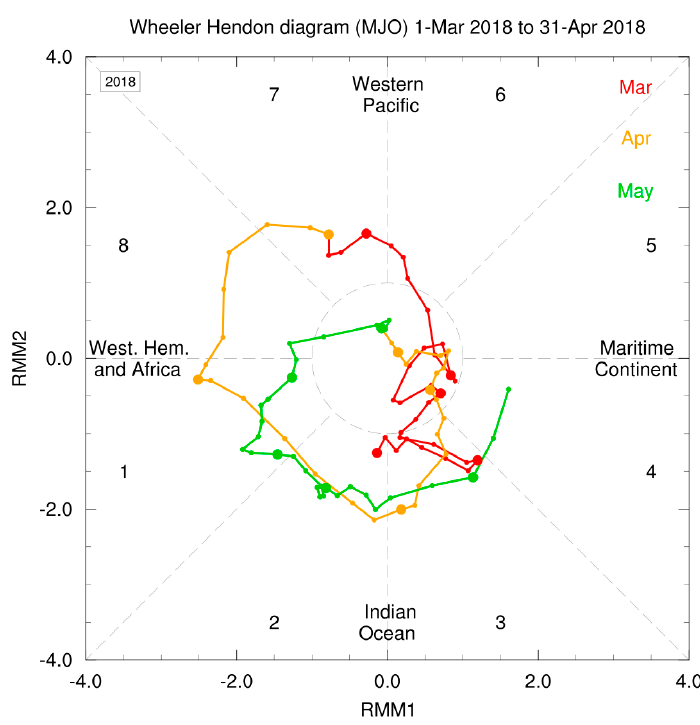
Figure 6. Madden–Julian Oscillation (MJO) activity during MAM 2018 plotted on a Wheeler–Hendon diagram. All of the days from March, April, and May 2018 are plotted in red, yellow, and green, respectively. For clarity, weekly intervals from the first day of each month are shown as larger circles (i.e., the first, eighth, 15 th , and 22 nd of the month). MJO data are from http://www.bom.gov.au/climate/mjo/. For interpretation, counter-clockwise movement around the diagram indicates an eastward propagating signal across eight phases from the Indian Ocean to the Pacific Ocean, and later the western hemisphere. The farther away from the center of the circle, the stronger the MJO signal.